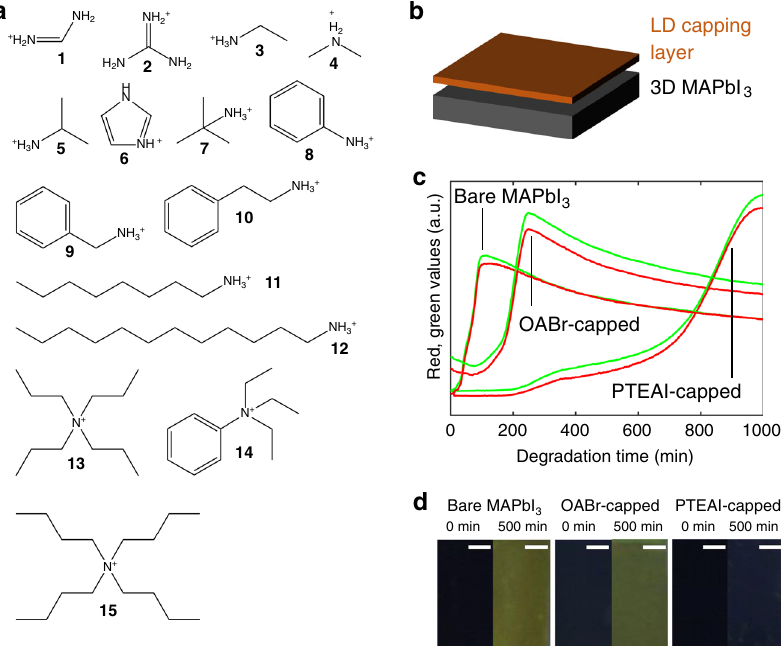
Fig. 2 Capping-layer precursors and accelerated aging results of best-performing capping-layer material. a A -site cations used in this study and their chemical structure: (1) formamidinium (FA), (2) guanidinium (GA), (3) ethylammonium (EA), (4) dimethylammonium (DMA), (5) iso -propylammonium (iPA), (6) imidazolium (ID), (7) t -butylammonium (tBA), (8) phenylammonium (PhA), (9) benzylammonium (BzA), (10) phenethylammonium (PEA), (11) n -octylammonium (OA), (12) dodecylammonium (DA), (13) tetrapropylammonium (TPA), (14) phenyltriethylammonium (PTEA), and (15) tetrabutylammonium (TBA). b The fi lm structure with 3D MAPbI 3 at the bottom and LD capping layer deposited atop. c The time-dependent red and green values of camera images, and d the camera images of pre-degraded and 500 min-degraded fi lms for bare MAPbI 3 control material, (11) OABr, used in state-of-the-art high-ef fi ciency devices, and (14) PTEAI, our best-performing material in this study, with scale bar 0.5